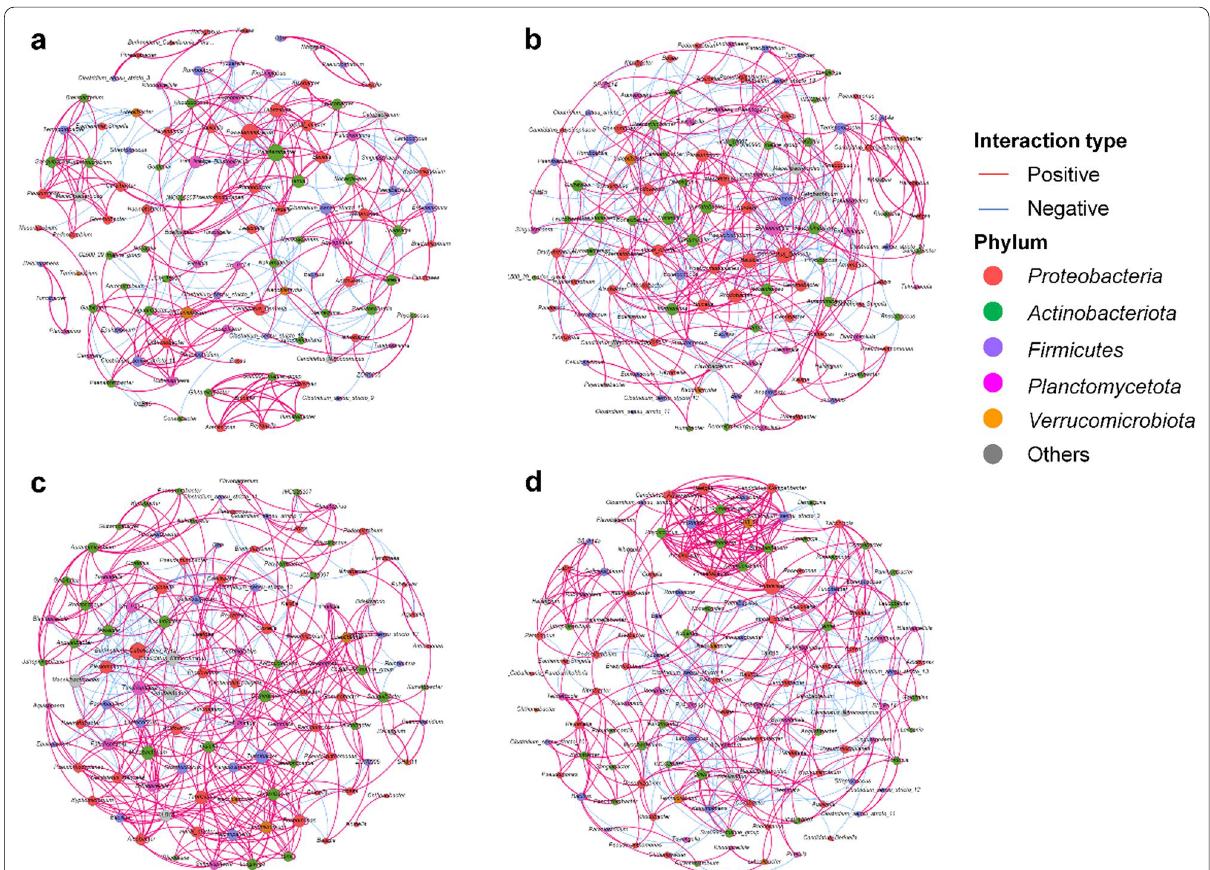
Fig. 6 Co-occurrence network in a FTS-M, b FTS-H, c BFS-M and d BFS-H at the end of Phase III (105 days of feeding). Red edge indicates the positive interaction and blue edge indicates the negative interaction. The size of node is proportional to its weight of degree, the nodes are coloured according to the phylum taxonomy. FTS flow-through system, BFS biofloc system, M moderate NSP diet, H high NSP